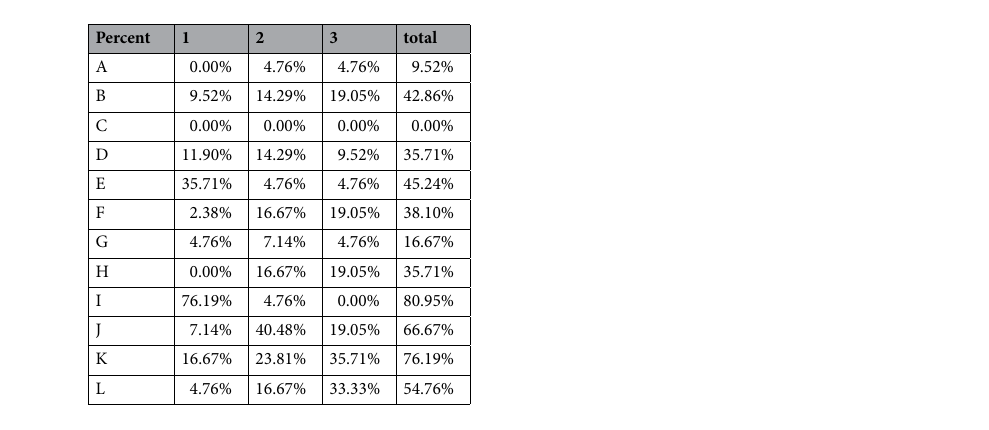
Table 7. Statistical table of importance percentage of